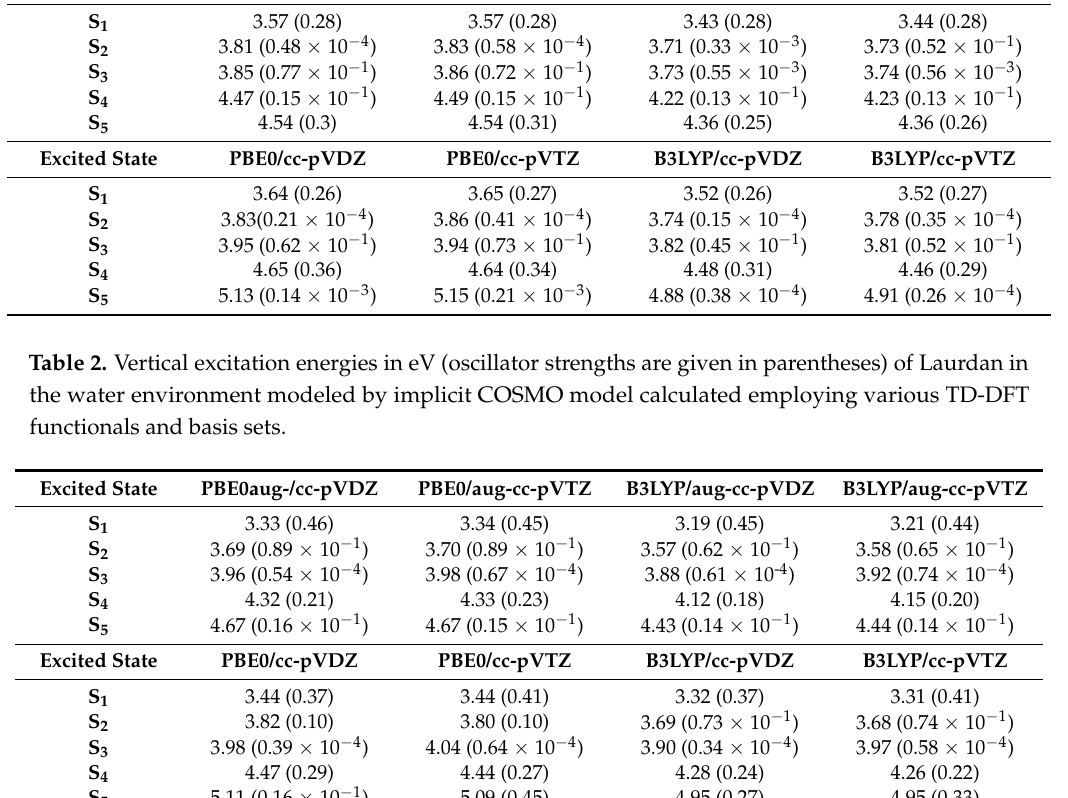
Figure 1. Optimized structure of ground state Laurdan fluorophore in the gas phase obtained using DFT PBE0/cc-pVDZ method. Color coding: Carbon–green, oxygen–red, nitrogen–blue, hydrogen–grey. Table 1. Vertical excitation energies in eV (oscillator strengths are given in parentheses) of Laurdan in the gas phase calculated employing various TD-DFT functionals and basis sets.